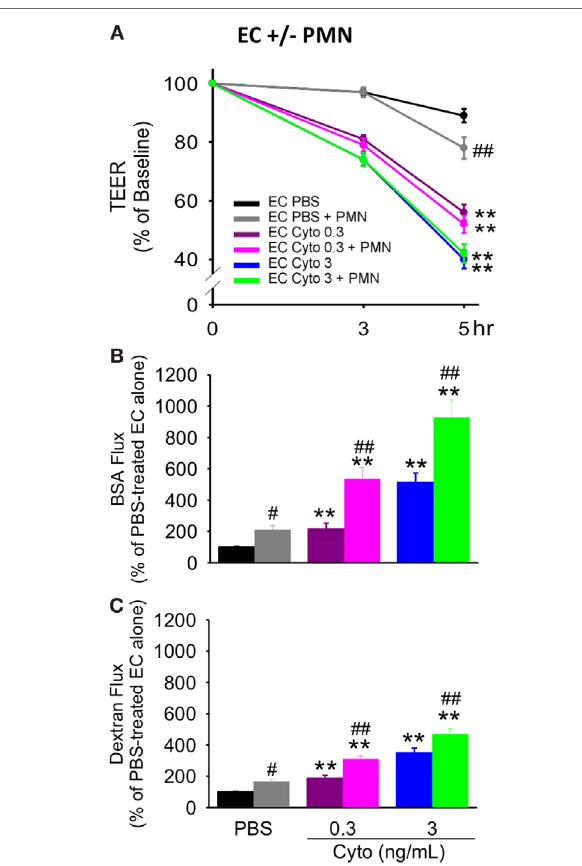
FigUre 4 | PMN coculture with PMVEC significantly augments septic trans-PMVEC macromolecular flux. Compared to human PMVEC alone, coculture of PMVEC with PMN led to significantly increased leak under basal (PBS) conditions, as assessed by three measures: transendothelial electrical resistance (TEER) (a) , Evans blue (EB)-bovine serum albumin (BSA) (B) , and fluoroisothiocyanate (FITC)-dextran (c) . Cytomix treatment (0.3 and 3 ng/mL) of PMVEC cultured alone or in coculture with PMN increased permeability, including decreased TEER and increased EB-BSA and FITC-dextran flux. However, under septic conditions, PMN–PMVEC coculture only significantly augmented macromolecular flux (B,c) compared to PMVEC alone. ** p < 0.01 compared with respective PBS-treated group; # p < 0.05 and ## p < 0.01 for PMN + PMVEC compared with PMVEC alone (two-way ANOVA). n =